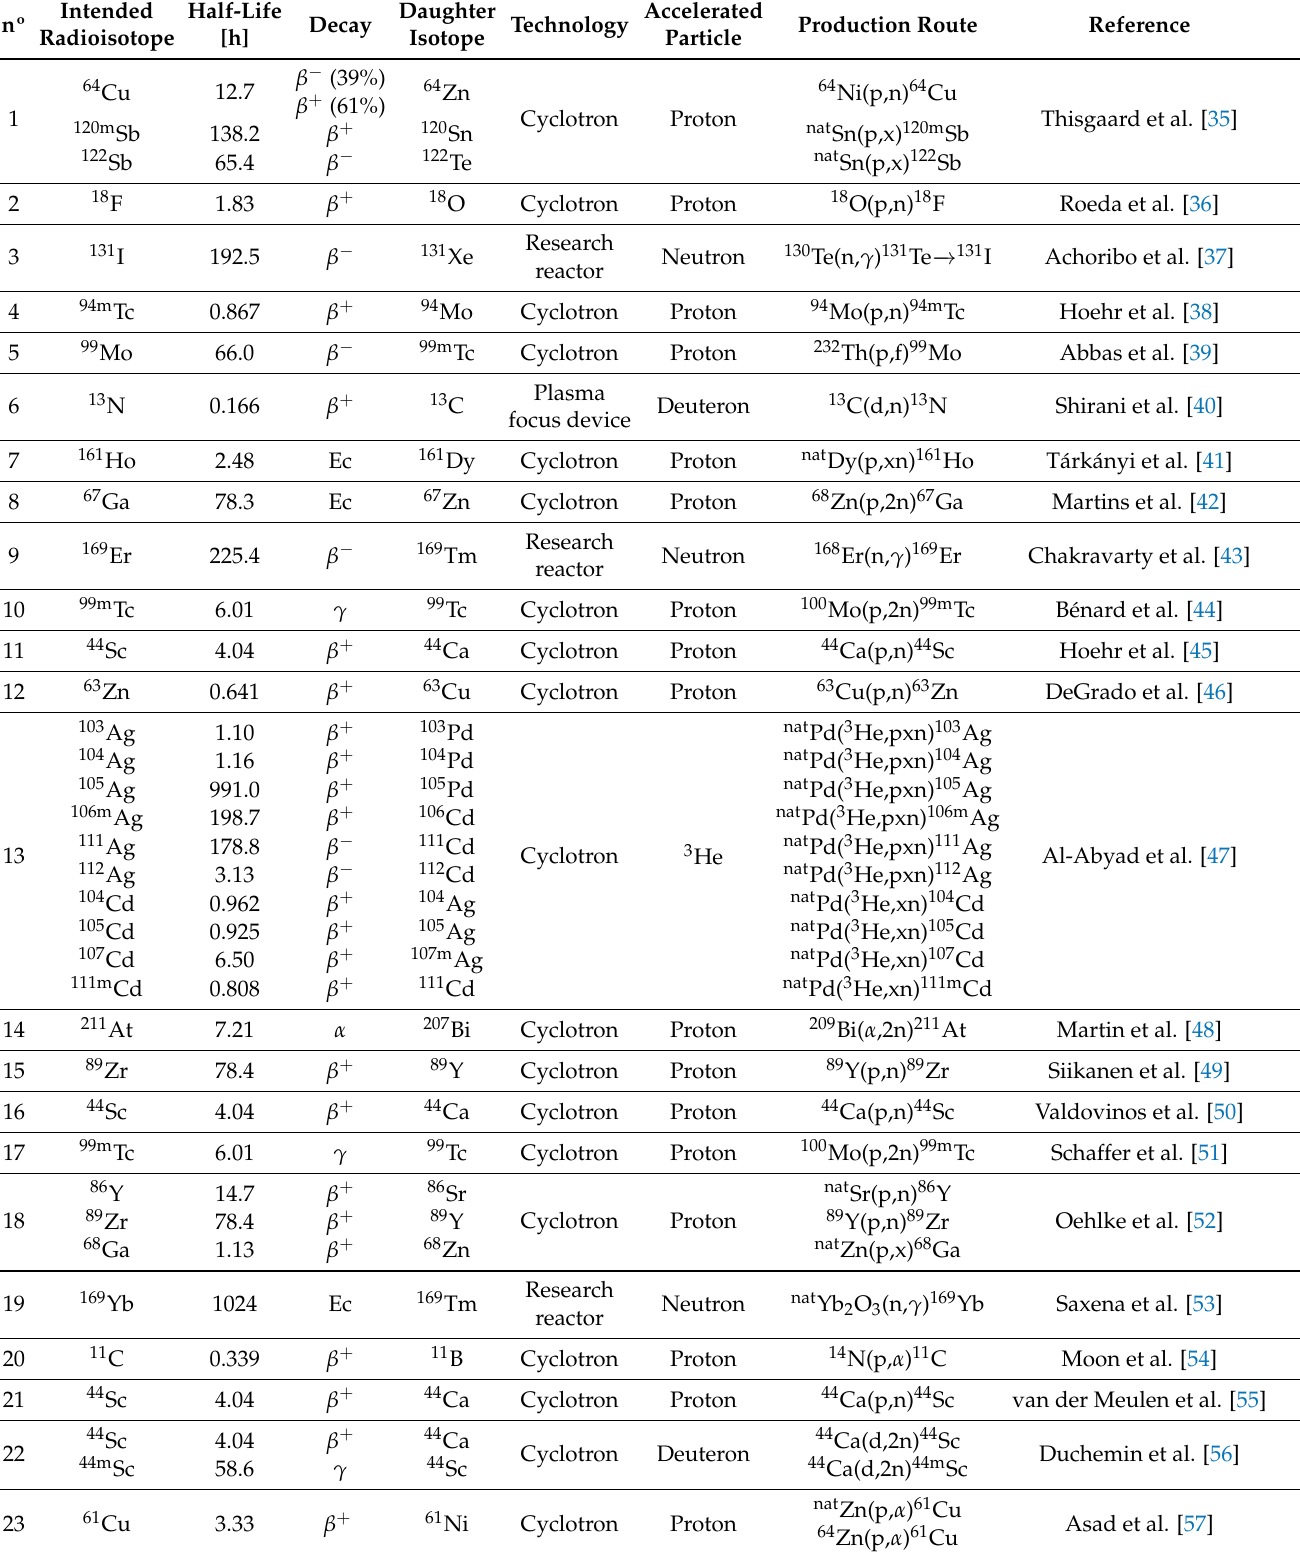
Table A1. Intended radioisotope production